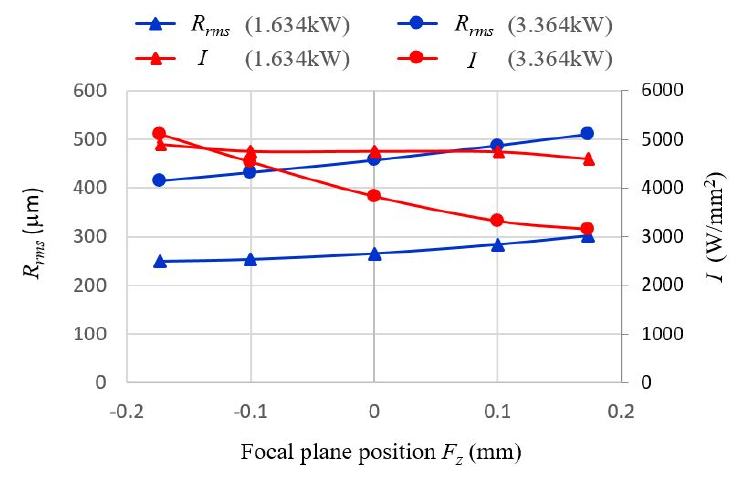
Figure 8. RMS spot radius R rms and optical intensity I as the function of focal plane position F z.